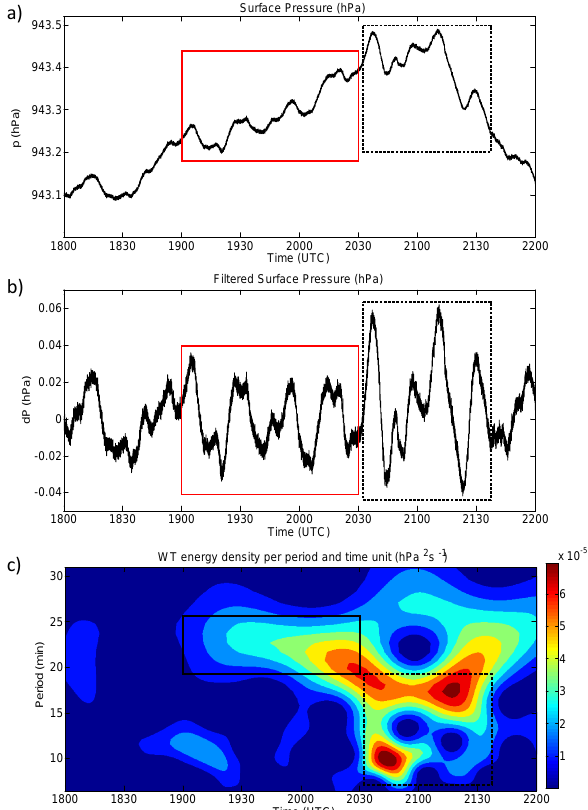
Figure 6. Absolute (a) and filtered (b) surface pressure (hPa) mea- sured by microbarometer A. (c) Morlet wavelet-based energy den- sity (hPa 2 s − 1 ). Wave event 1 is indicated with red rectangles (black in c ) and wave event 2 with dashed black rectangles. Note: these fig- ures are almost identical for microbarometers B and C.